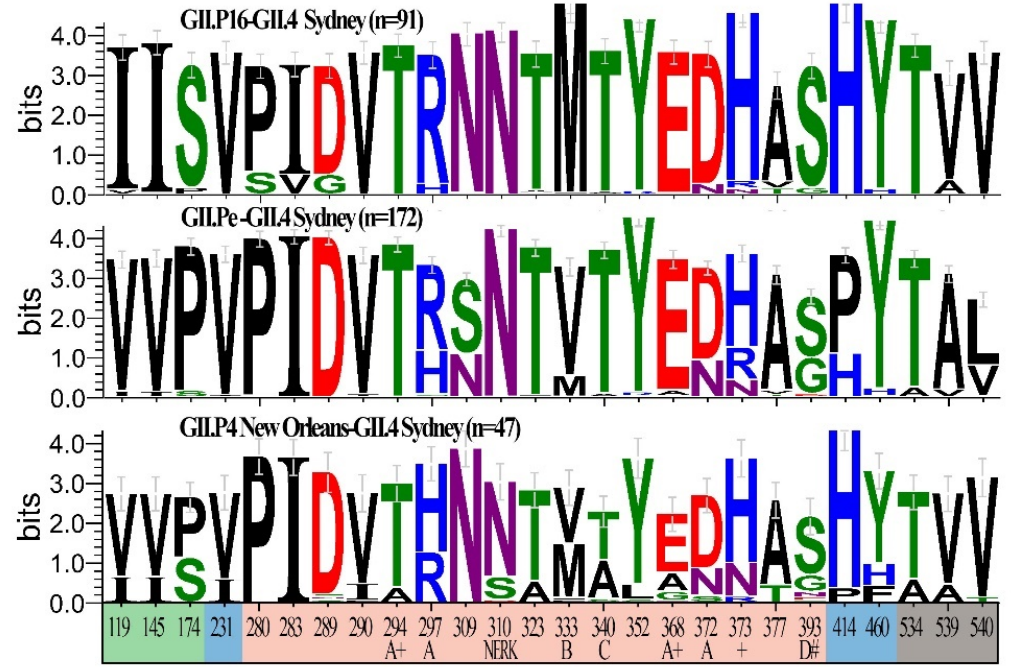
Figure 5. Informative amino acid sequences within the VP1 protein of GII.4 Sydney viruses with and without the novel GII.P16 polymerase. Sequence logos indicating the relative frequency of amino acid occurrence (bits) for locations where >10% of sequences with a different polymerase type differed from those with a novel GII.P16 polymerase for GII.4 Sydney strains with a novel GII.P16 ( n = 91 sequences), GII.Pe ( n = 172 sequences) or GII.P4 New Orleans ( n = 47 sequences) polymerase. Bottom numbers indicate amino acid position within VP1 and colors indicate Shell (green), Protruding one (blue), Protruding 2 (peach) and C-terminal (grey) domains. Sites involved in neutralizing antibody recognition (epitopes A, B, C and D), the NERK motif, and histo-blood group antigen binding (#), as well as those under positive selection (+) are indicated.